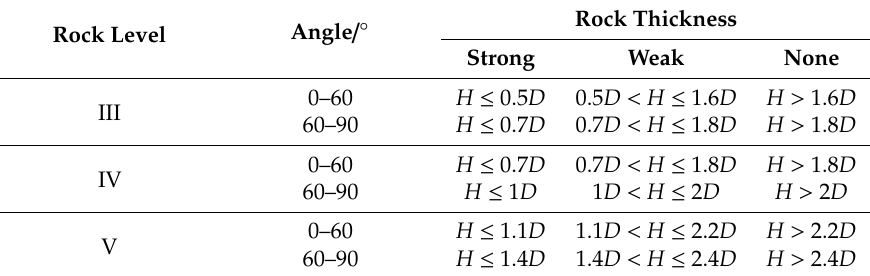
Table 12. Influence zoning of HSR cross tunnels for train speed = 350 km /